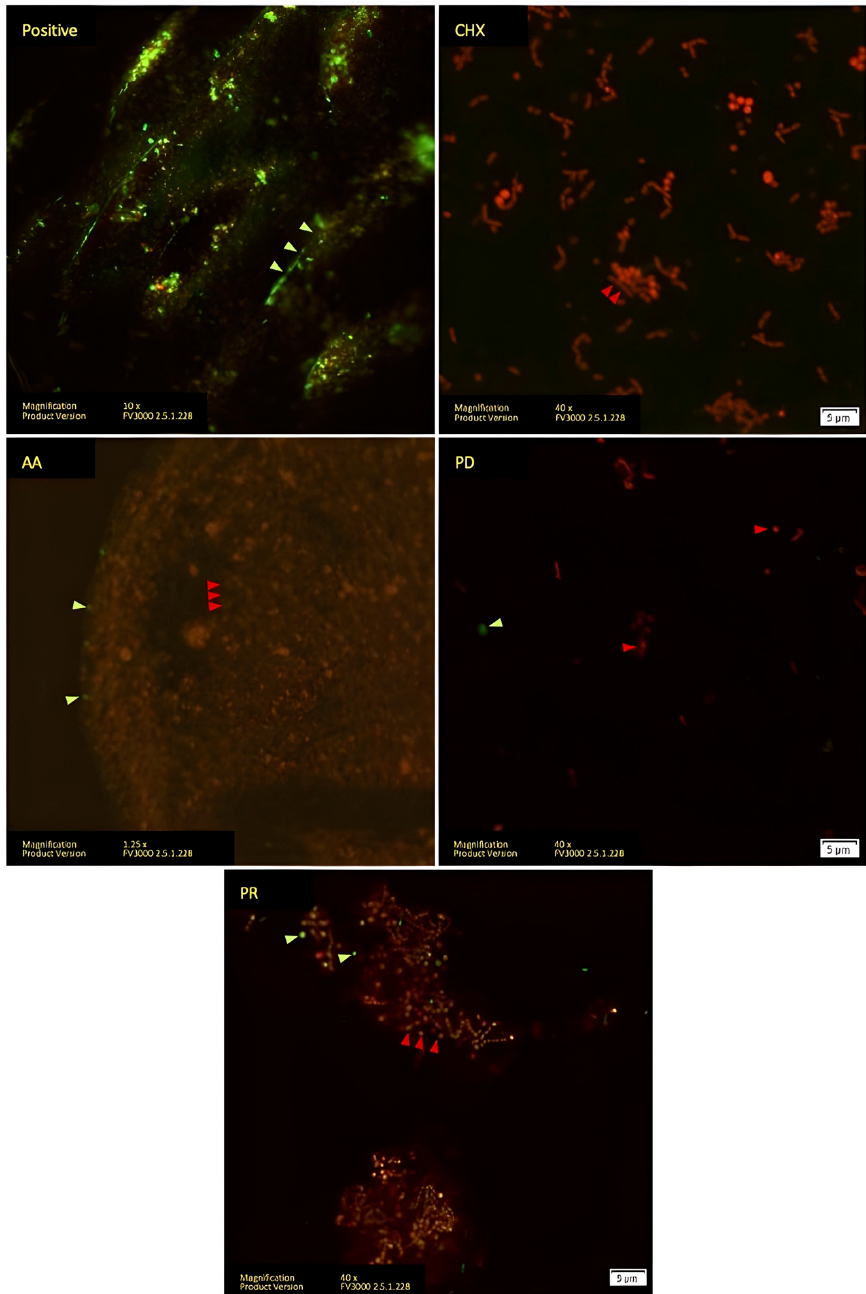
Figure 3. LIVE/DEAD staining analyzed with confocal microscope of Vivera ® retainer. Living cells stained with SYTO9 are indicated with green arrows. Dead cells stained with PI are indicated with red arrows.